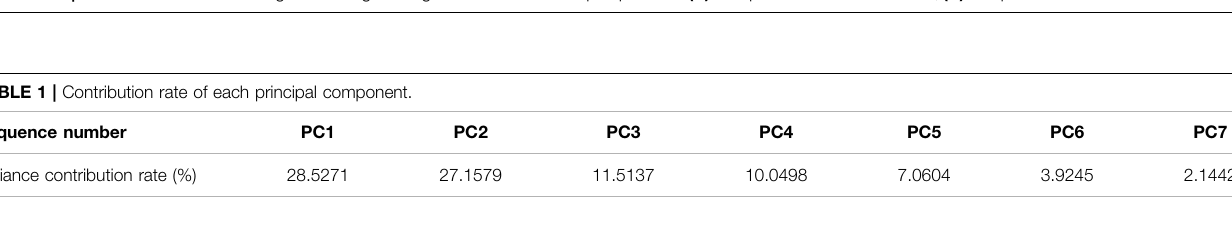
Table 1 . The contribution rate of the principal component refers to the proportion of variance of the principal component in the total variance of the data. As shown in Figure 4 and Figure 7 , the dataset can be roughly divided into fi ve categories: air background, water hole, air hole, defection-free zone, and metal shield zone. A part of the signal from these fi ve types of data zones is selected as a standard feature dataset and is trained to build signal feature models. The training sets are listed in Table 2 .